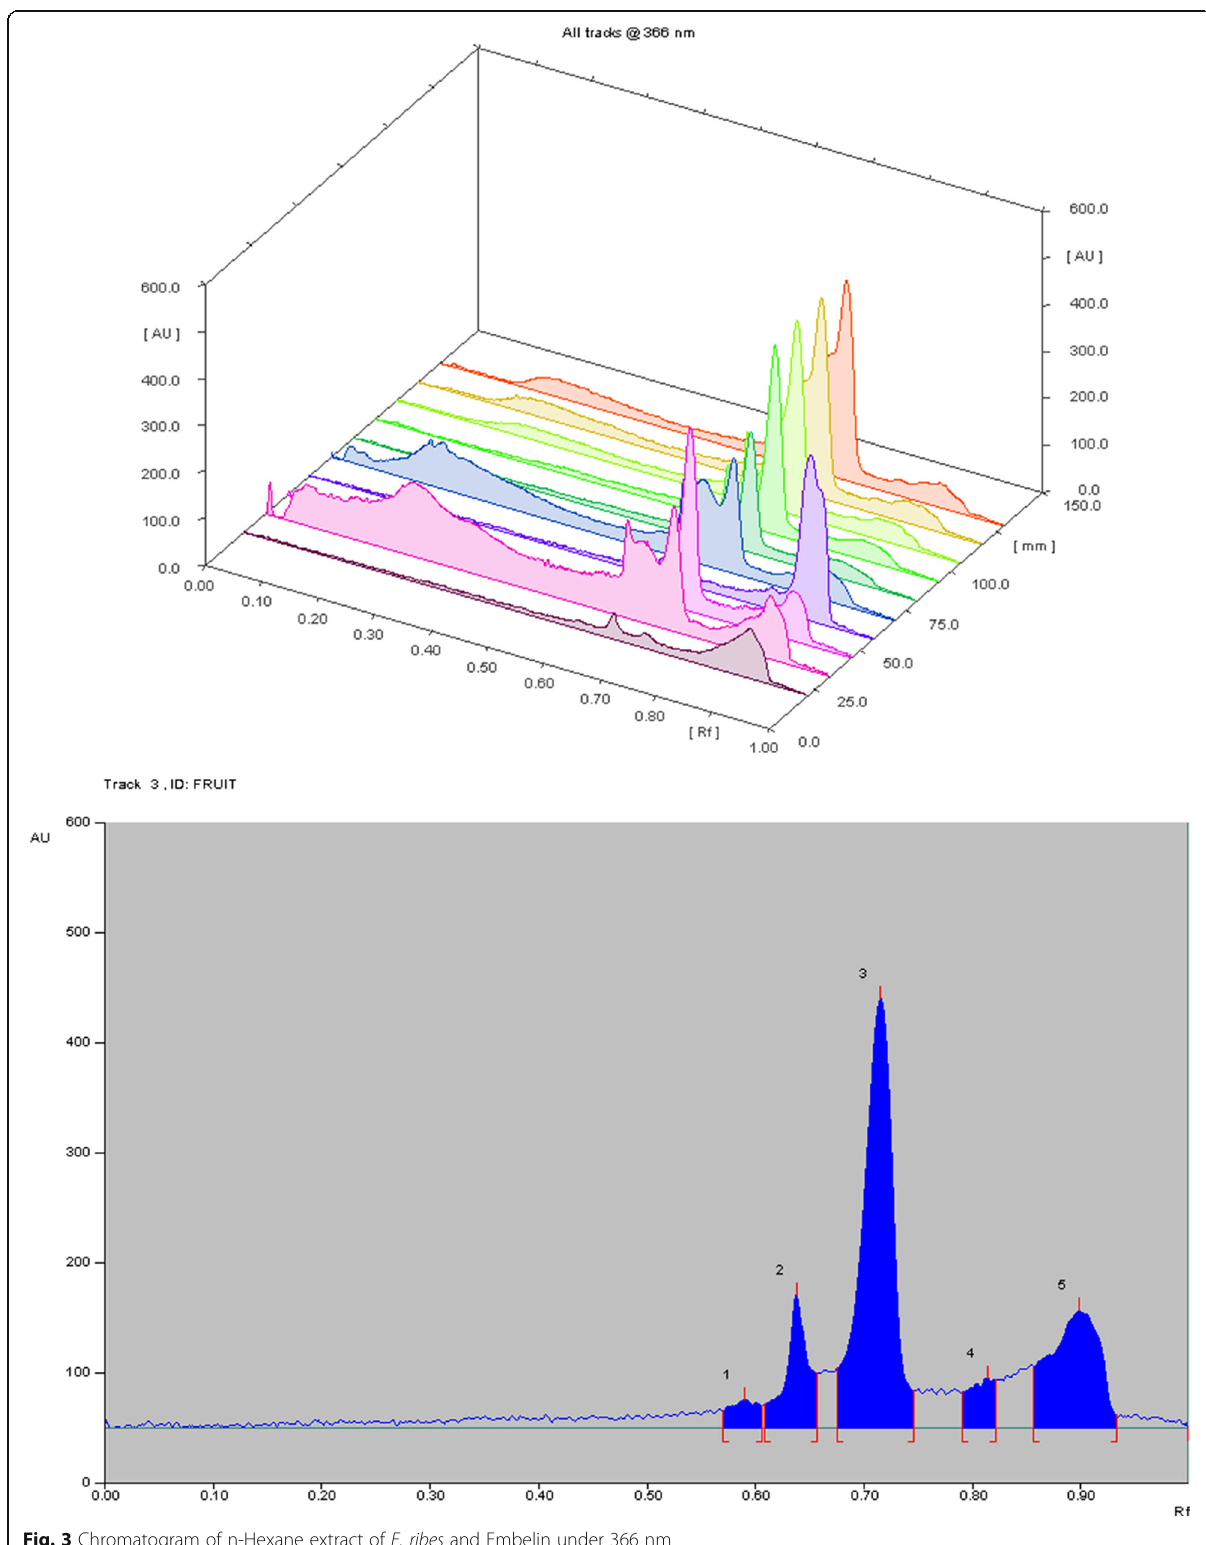
Fig. 3 Chromatogram of n-Hexane extract of E. ribes and Embelin under 366